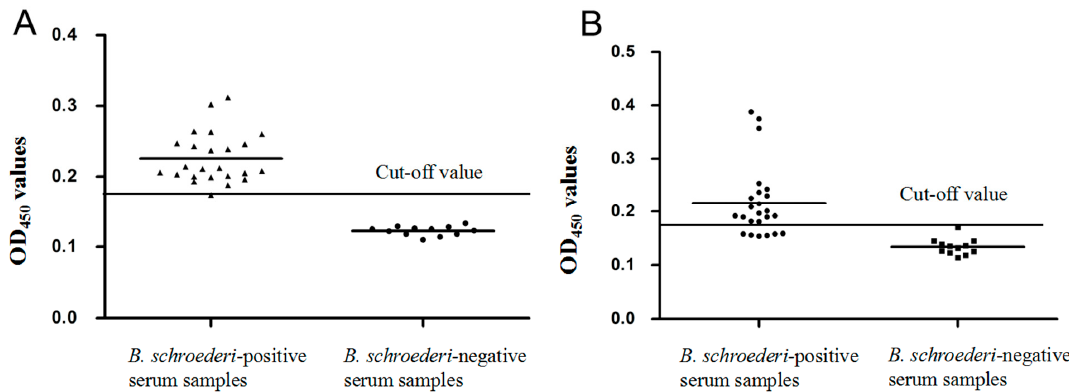
Figure 6. Indirect enzyme-linked immunosorbent assay (ELISA) for the detection of giant panda infected with B. schroederi . ( A ) Sensitivity and specificity of the indirect ELISA based on recombinant Bs-GAPDH. The cut off value is 0.179. Statistically significant differences between B. schroederi -positive sera and healthy giant panda sera were tested by t -test ( t (34) = 26.016, p < 0.0001). ( B ) Sensitivity and specificity of the indirect ELISA based on recombinant Bs-Tpx. The cut off value is 0.161. Statistically significant differences between B. schroederi -positive sera and healthy giant panda sera (Mann–Whitney U, z = − 4.632, p < 0.0001).